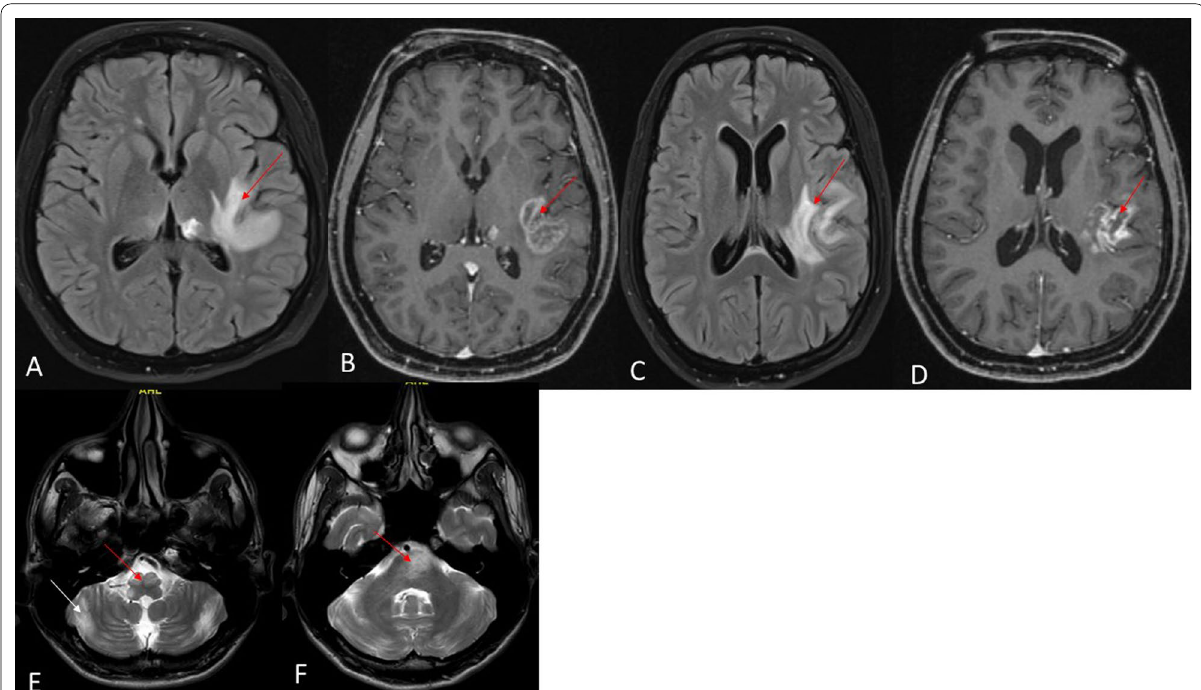
Fig. 3 MRI brain of patient 2 ( A – D ). A , C axial FLAIR images show hyperintense lesion in left thalamus, internal capsule and peri-insular region (red arrows); B , D T 1- contrast images show contrast enhancement in left thalamus, internal capsule and peri-insular region (red arrows); E , F axial T 2 images of patient 7 shows hyperintense lesions in medulla, cerebellum and pons (red and white